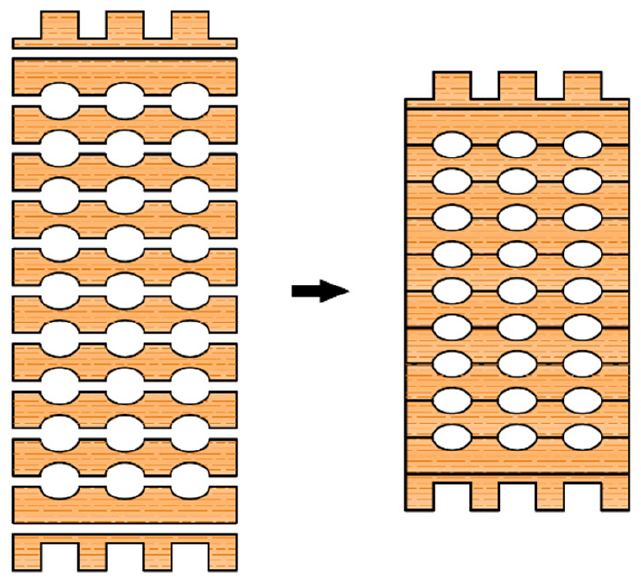
Figure 2. Individual lamellae of the element with elliptical holes and the cross-section of the assem- bled hollow glued laminated timber element.